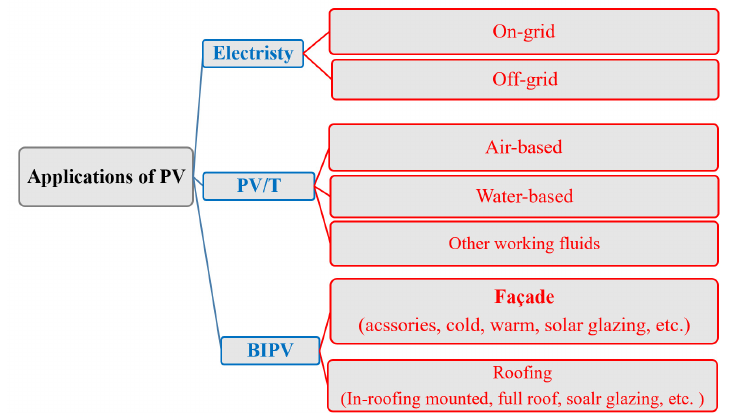
Figure 2. Application of PV modules throughout the benchmark analysis.